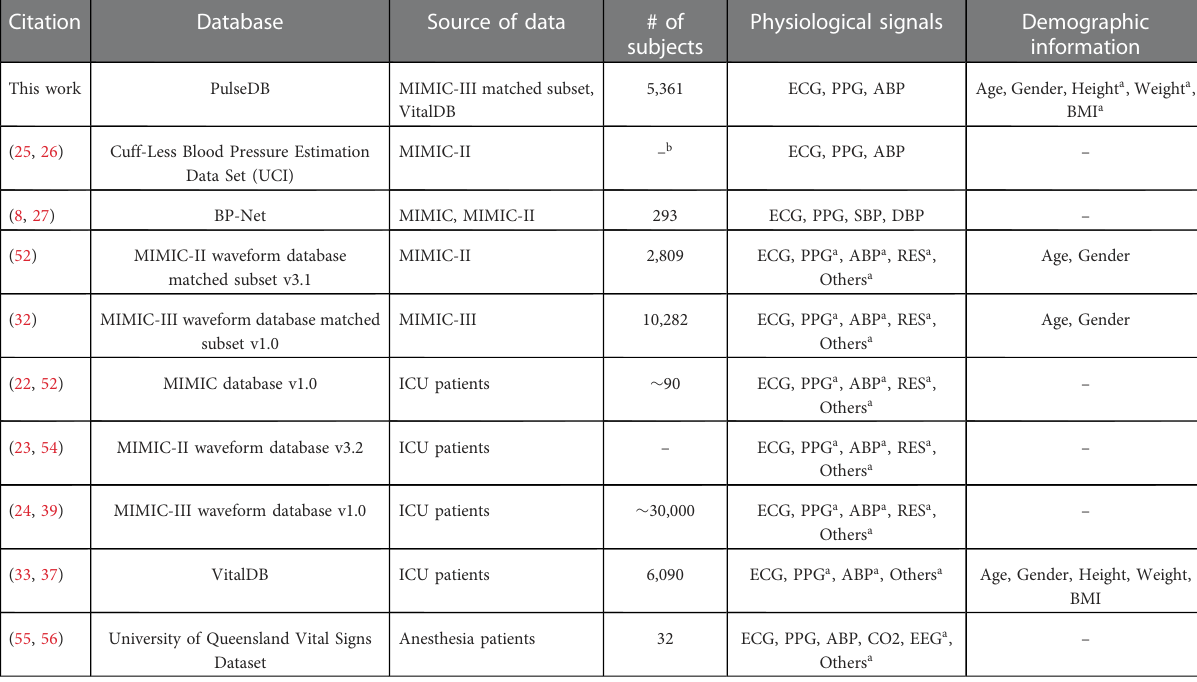
TABLE 6 Comparison between the proposed PulseDB dataset and other cardiovascular signal datasets that have been frequently used in cuff-less BP estimation